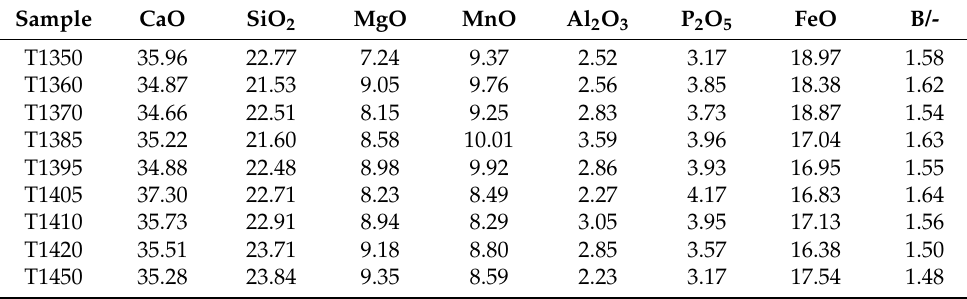
Table 3. Compositions and basicities of dephosphorization slag (mass%).